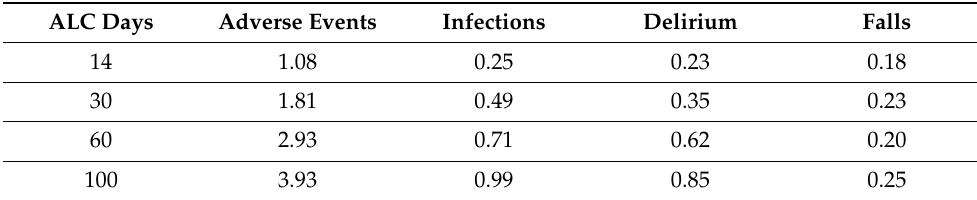
ALC Days ALC Days